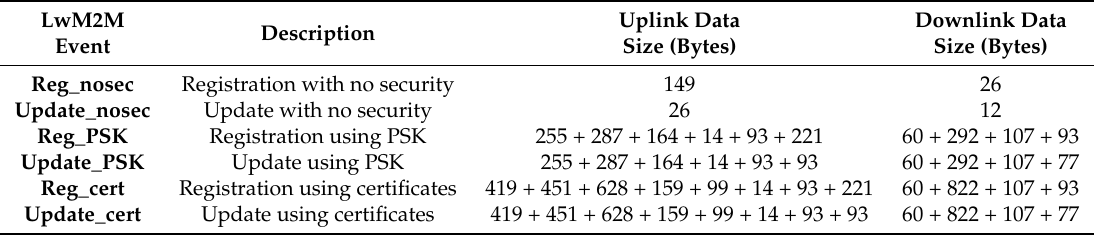
Figure 4. Handover diagram. Table 1. Table for data sizes and direction for different LwM2M